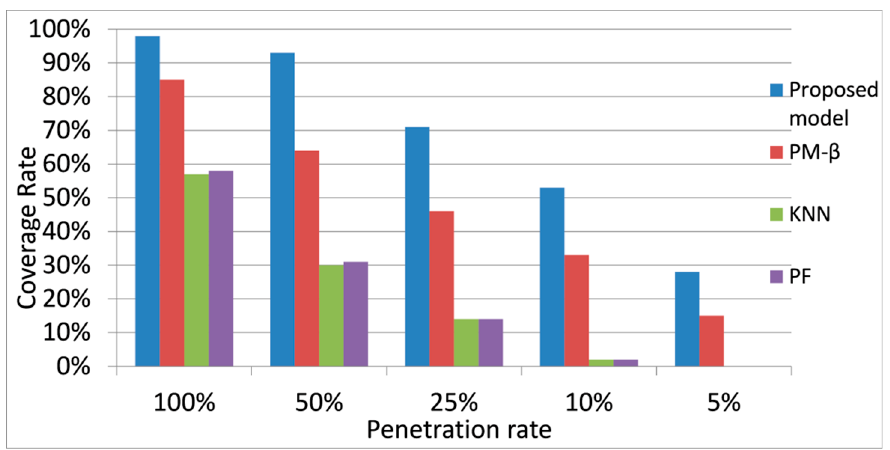
Figure 7. Coverage rate under different penetration rates.